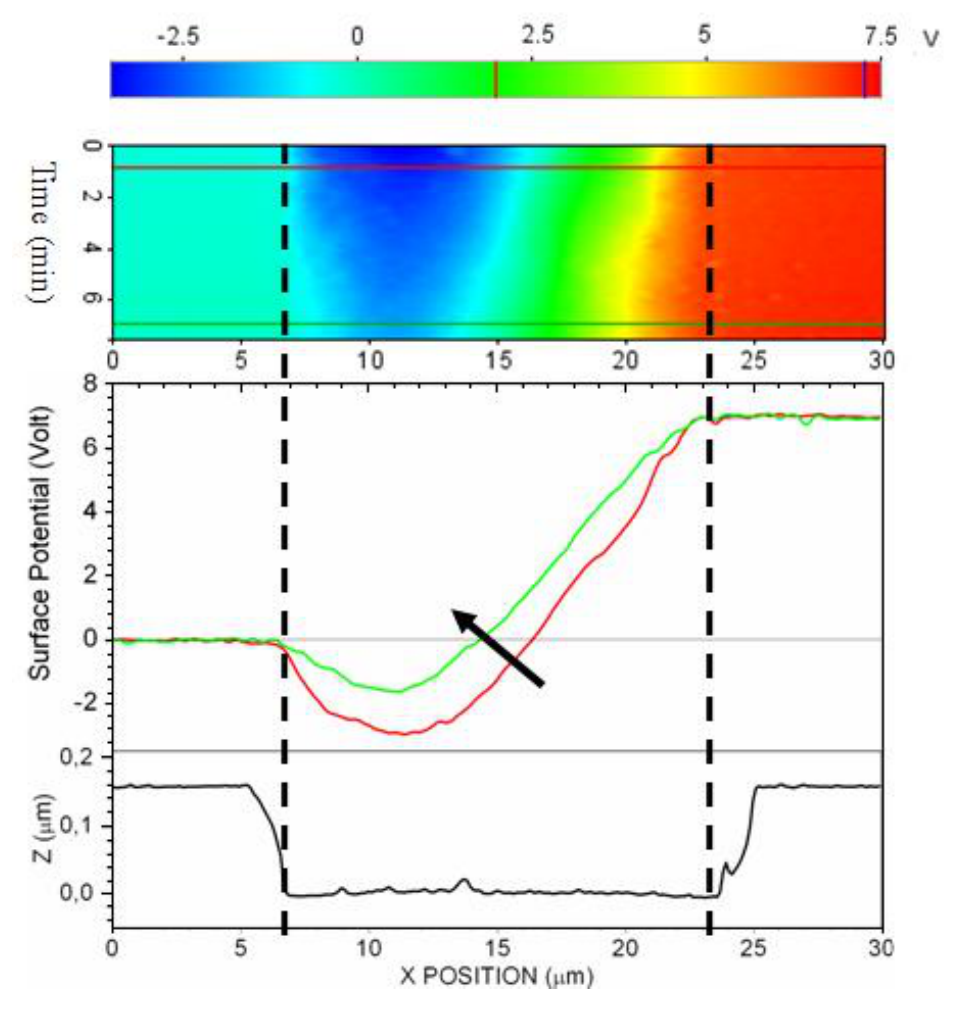
Figure 4. ( top panel ) Time evolution of the potential along a line across the channel, the upper bar is the chromatic scale for the potential values; ( middle panel ) graph of potential of two specific lines at the beginning (red lines) and the end (green lines) of the experiment, the arrow indicates increasing time; ( bottom panel ) topographic profile of the channel acquired contemporarily with potentiometric measure. Vertical dashed lines are guides for eyes to indicate where the gold contacts